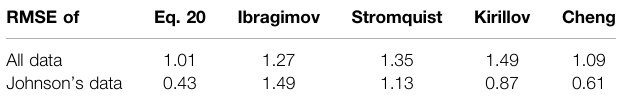
TABLE 2 | RMSE results of relations based on literature data.